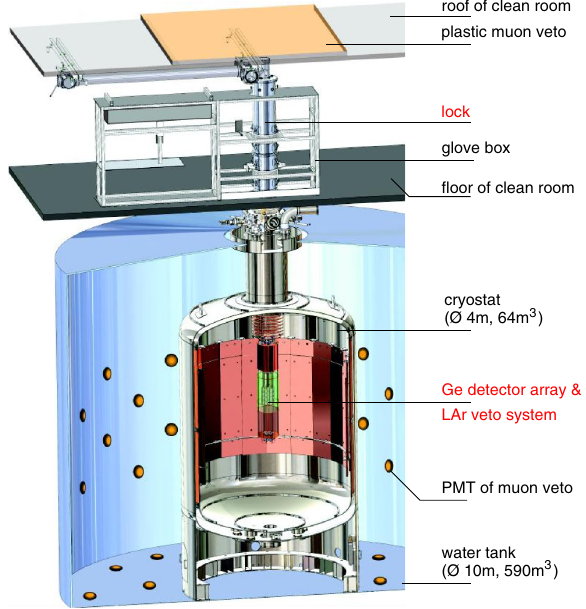
Fig. 1 Gerda setup. The new Phase II components are labeled in red